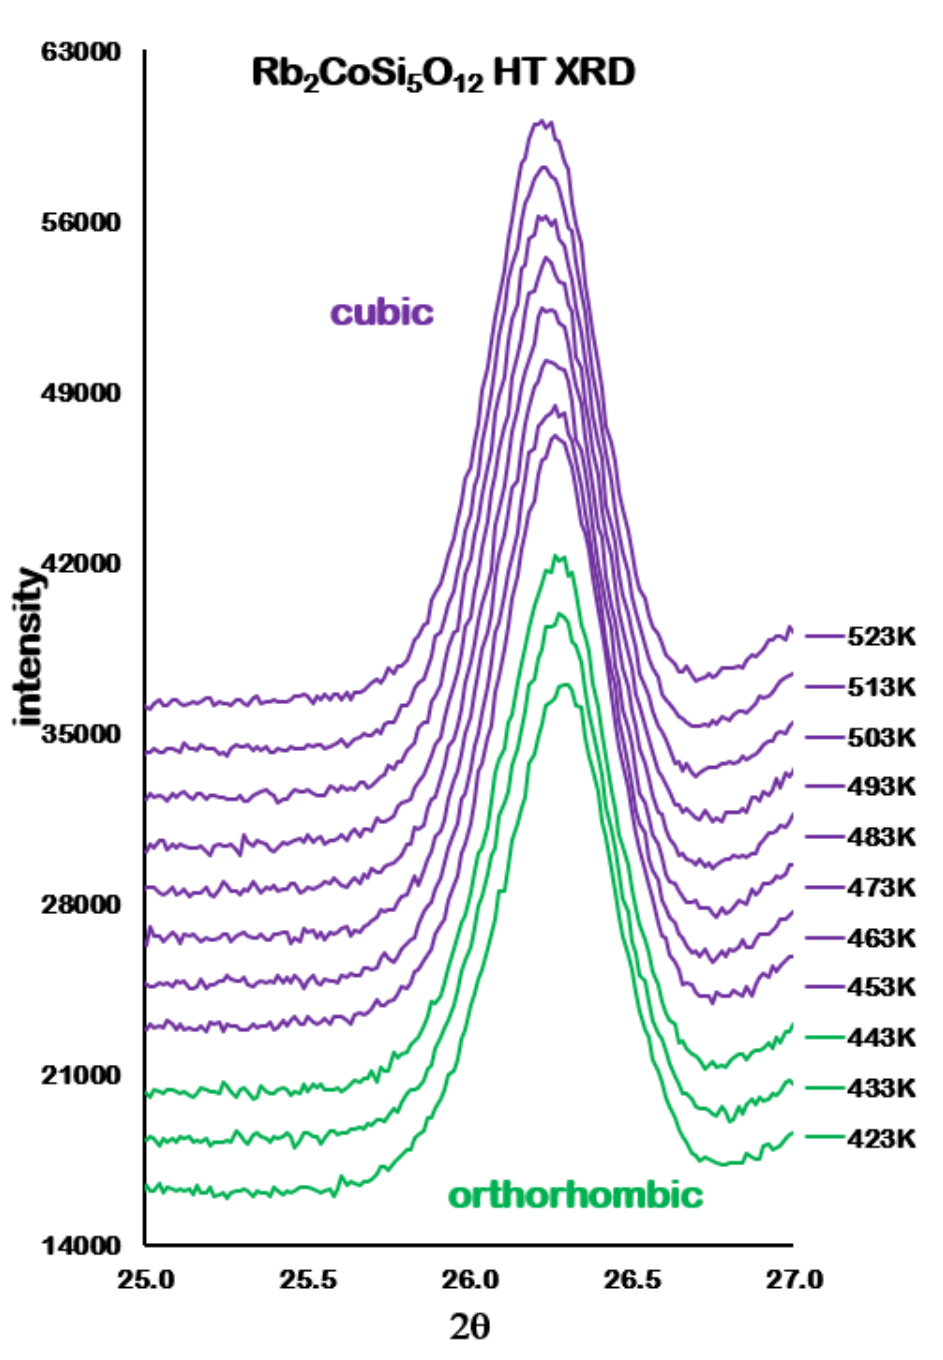
Figure 6. Plot showing XRD data for Rb 2 CoSi 5 O l2 25–27 °2 θ over the temperature range 423–523 K. This shows how three closely overlapped 004, 040 and 400 Pbca orthorhombic Bragg reflections (green) merge to form a single 𝑃𝑎 3 cubic 400 Bragg reflection (purple) on heating.